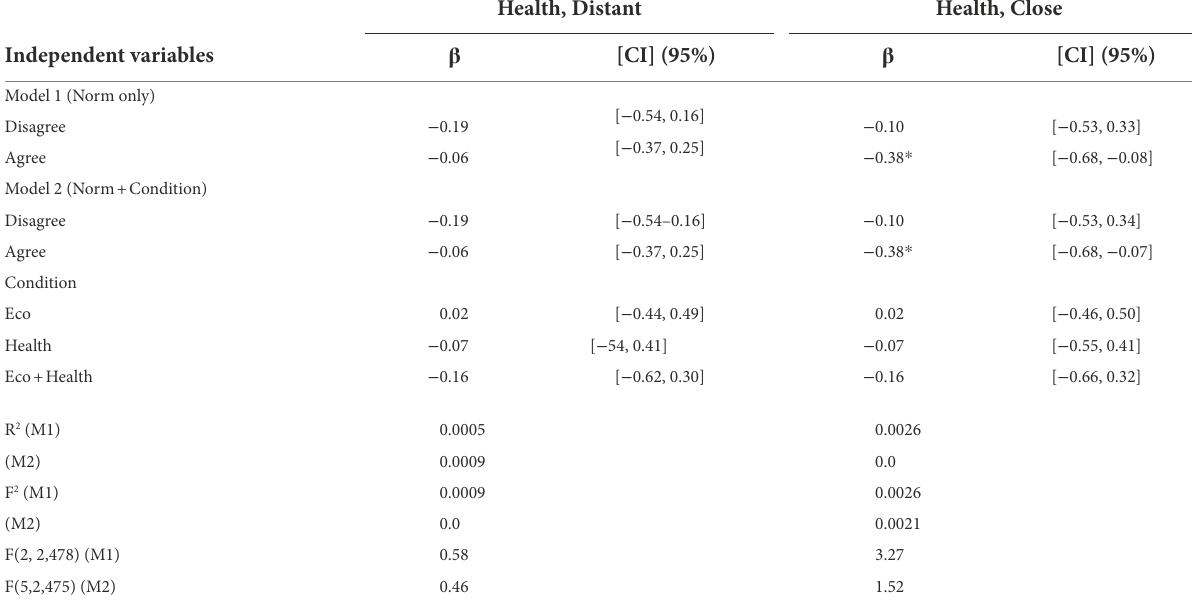
TABLE 4 Linear Regression Models for effects of health social norms and intervention condition on health impact of shopping baskets. Health, Distant Health,